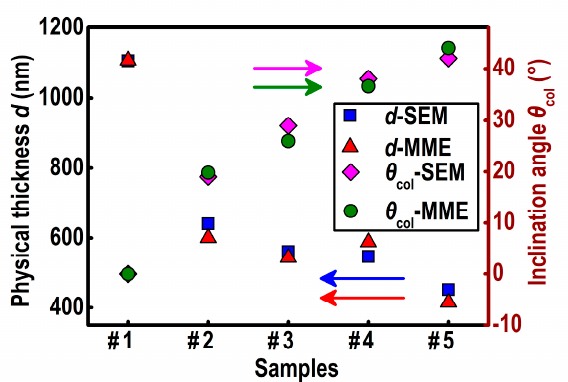
Figure 6. Physical thickness d and inclination angle θ col of YF 3 films measured by SEM and Mueller matrix ellipsometry matrix ellipsometry (MME).